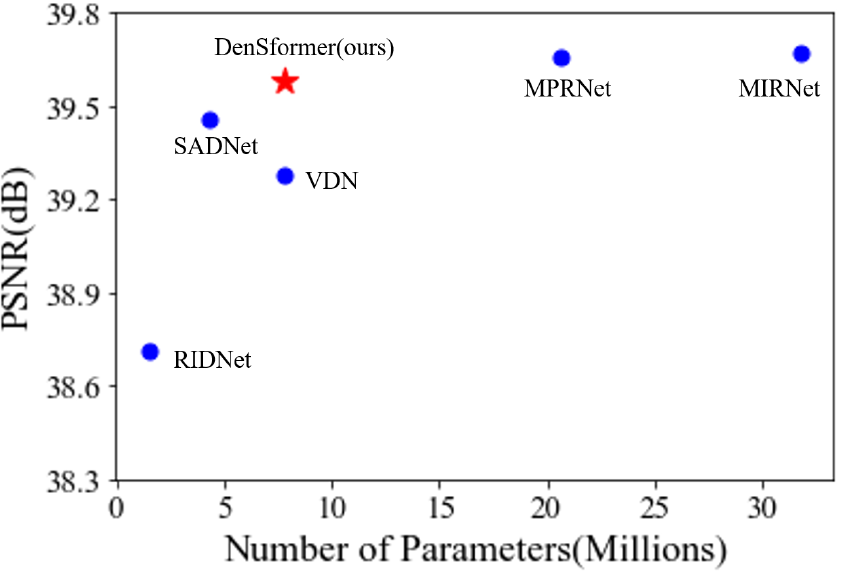
Figure 7. PSNR results v.s. number of parameters of different methods for denoising on